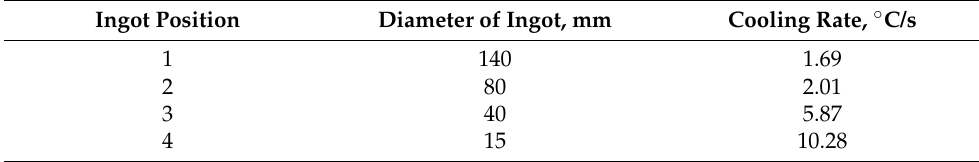
Table 2. Average cooling rate of billets with different diameters during solidification. Ingot Position Diameter of Ingot, mm Cooling Rate, ◦ C/s